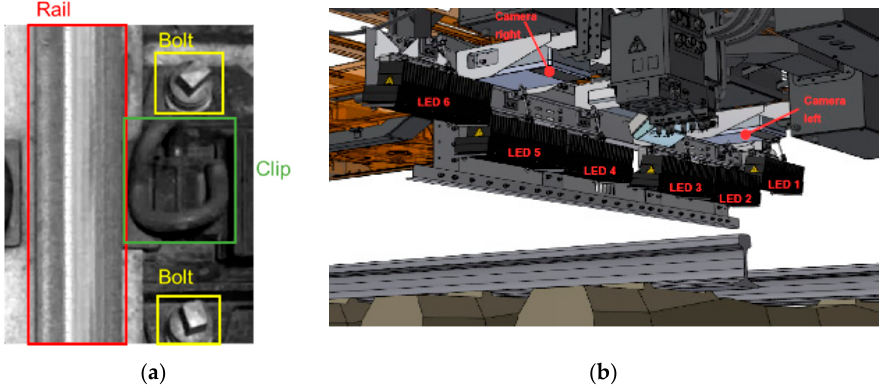
Figure 1. ( a ) Key railway components: rail, bolt, and clip; ( b ) Locations of lights and cameras.